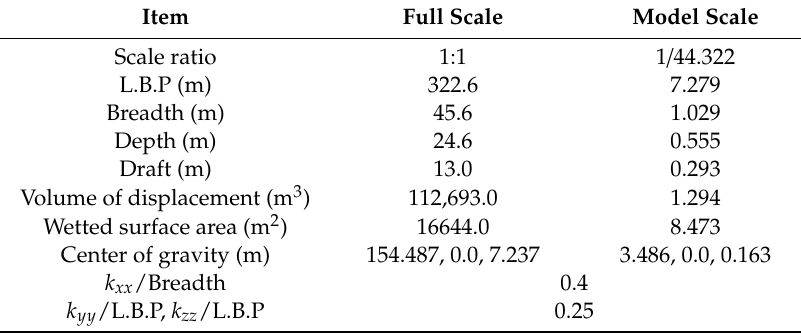
Table 1. Principal dimensions of the 8000 TEU-class container ship (center of gravity means, from A.P. (Aft Perpendicular) to F.P. (Forward Perpendicular), centerline, from baseline to